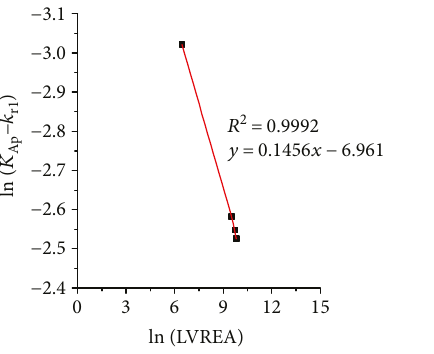
Figure 12: Adjustment for dependence of K